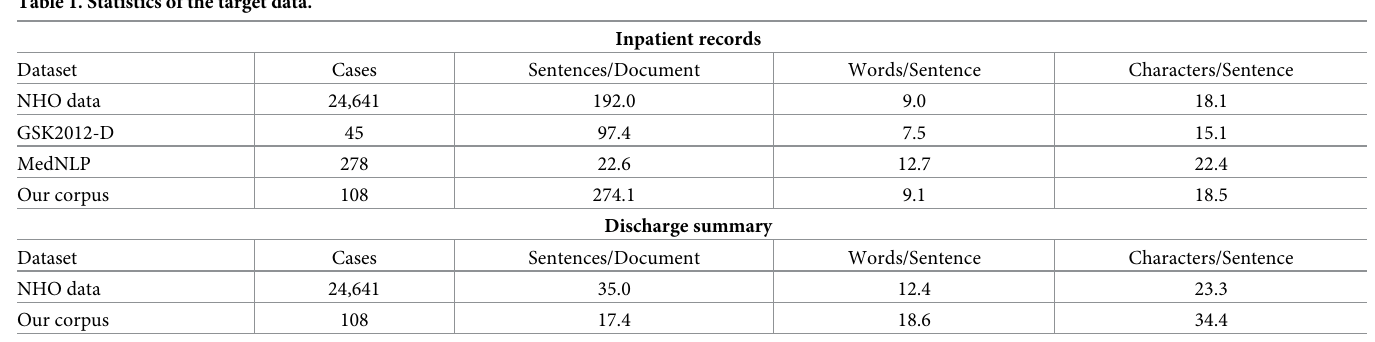
Table 1. Statistics of the target